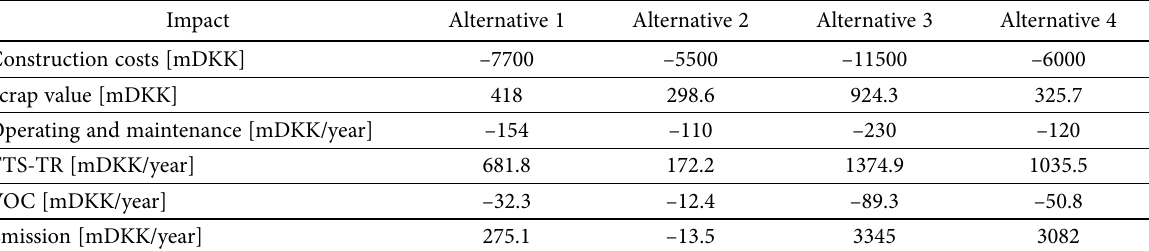
Table 2. CBA impacts for the assessment of the HH-Connection project (adapted from Larsen, Skougaard 2010) Impact